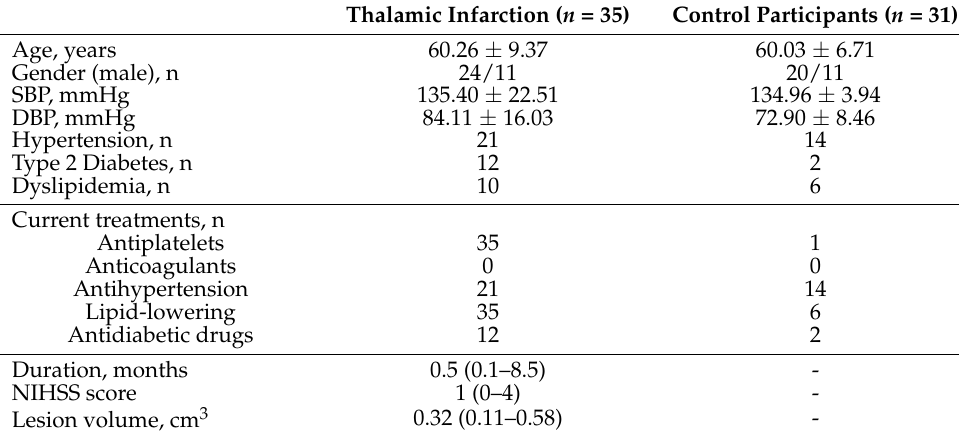
Table 1. Demographics and clinical